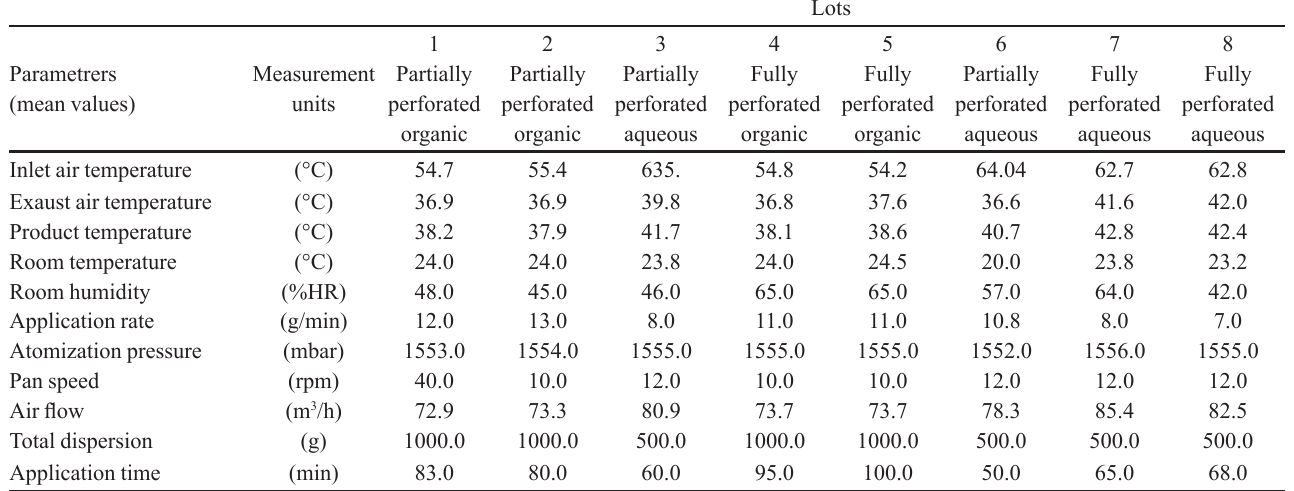
TABLE IV - Conditions adopted in the tablet coating step for lots 1 to